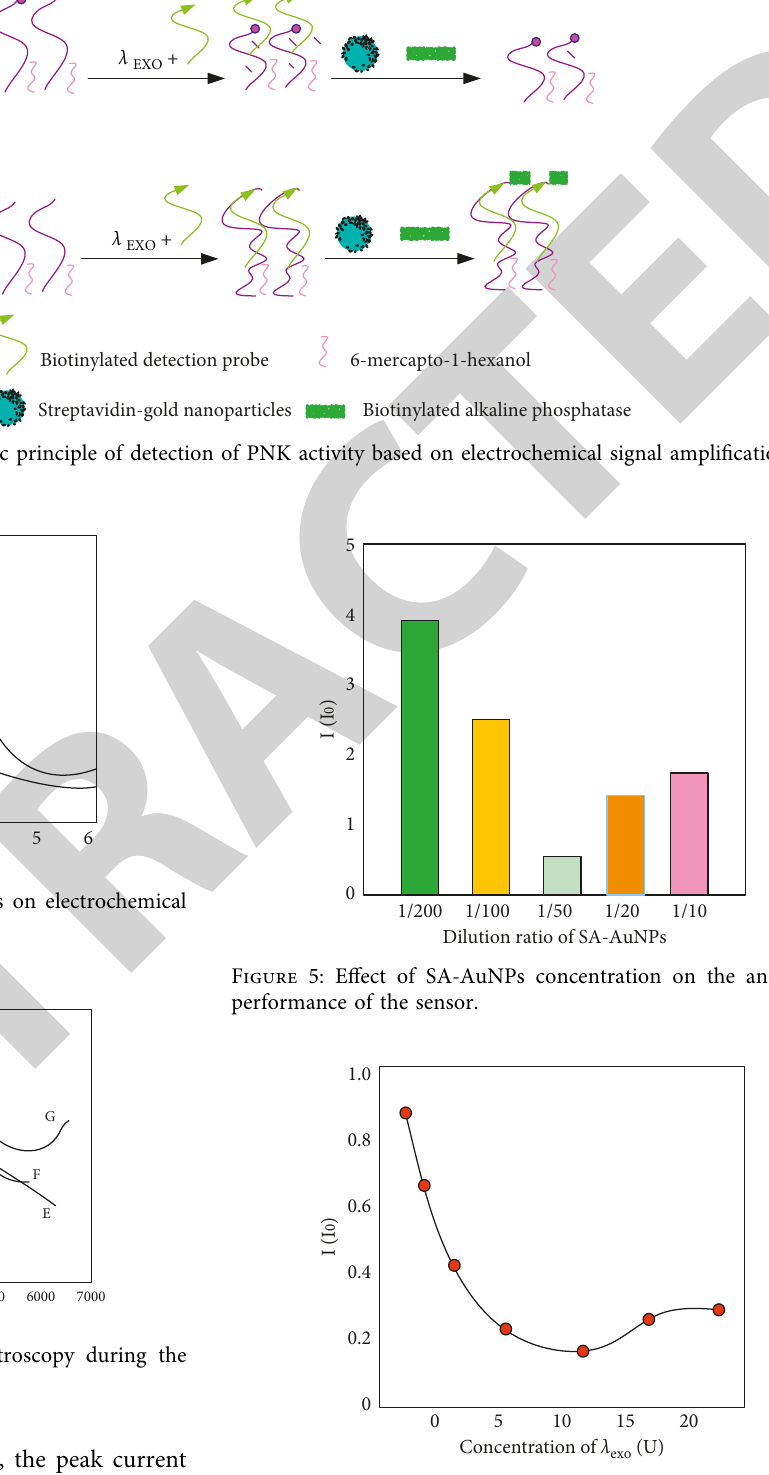
Figure 6: The effect of the amount of λ exonuclease on the ana- lytical performance of the Figure 8(a) is a DPV response profile of different active concentrations of PNK. The active concentrations of PNK from top to bottom are 0, 0.01, 0.05, and 0.1 U/mL.